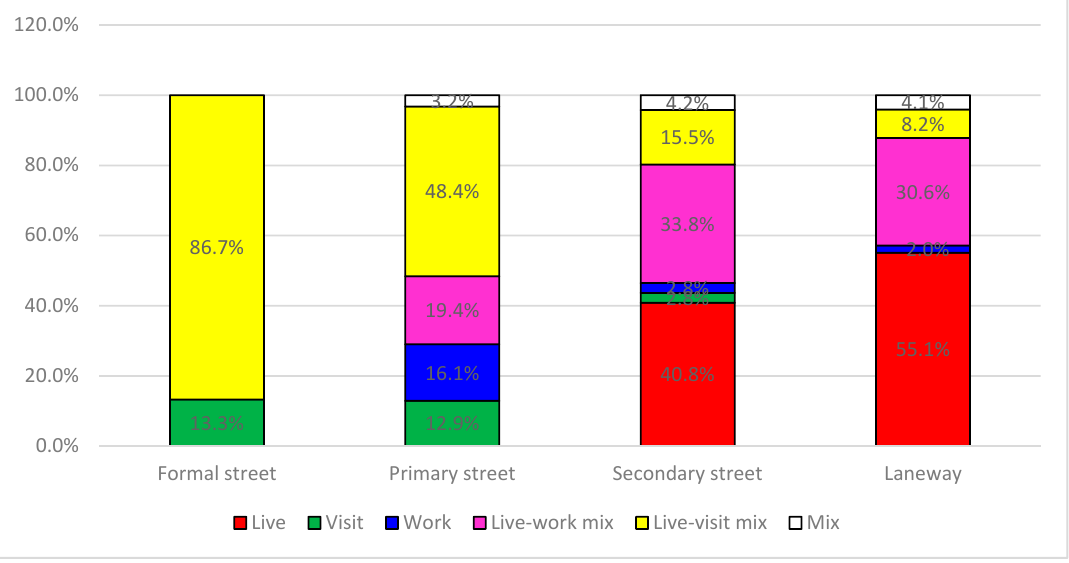
Figure 13. Map of the functional mix.